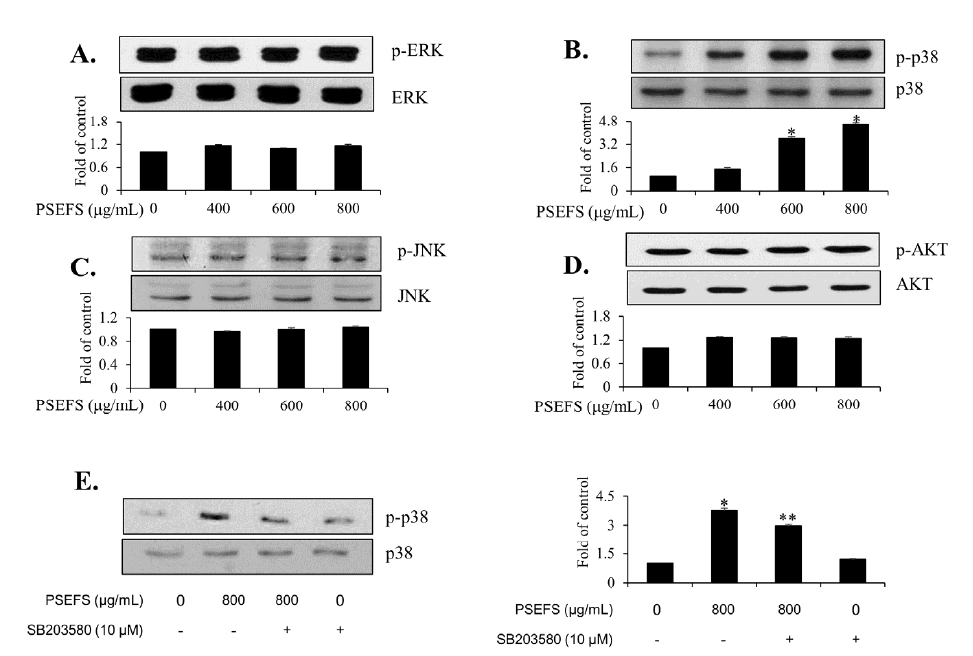
Figure 3. PSEFS promotes the phosphorylation of p38 MAPK in T24 cells. ( A – D ) Changes in phosphorylated levels of MAPKs (JNK, ERK1 / 2, and p38 MAPK) and AKT according to immunoblot. ( E ) Verification of p38 MAPK phosphorylation using SB203580 (a specific p38 MAPK inhibitor). Bar graphs show fold-changes in expression relative to controls. Data represent the mean ± SD of triplicate experiments. * p < 0.05, PSEFS-treated group vs. control; ** p < 0.05, PSEFS + SB203580-treated group vs. PSEFS-treated group.